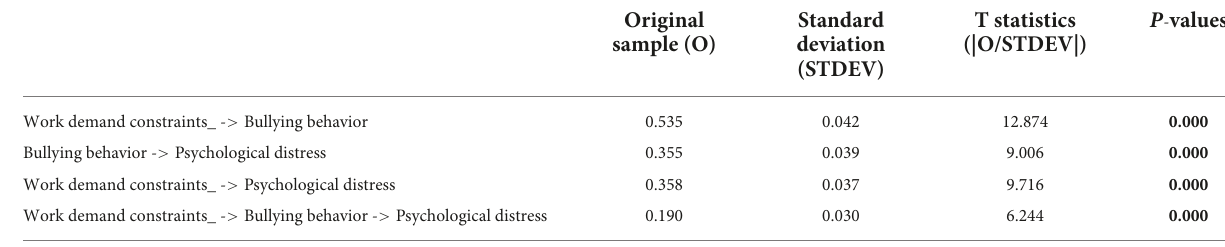
TABLE 5 Regression coefficients.